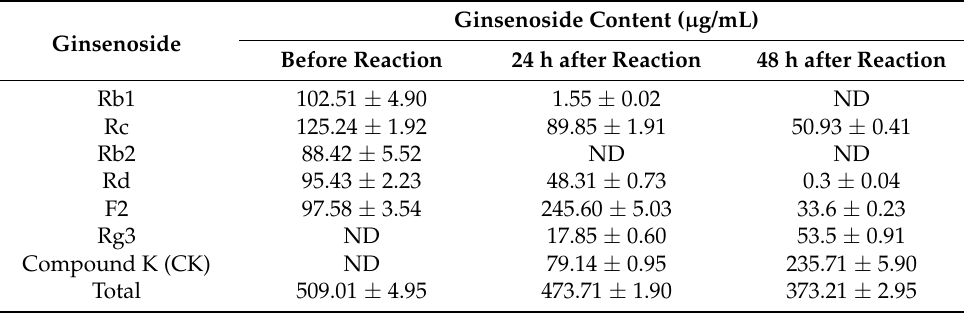
Table 3. Changes of PPD type ginsenosides during the enzymatic conversion